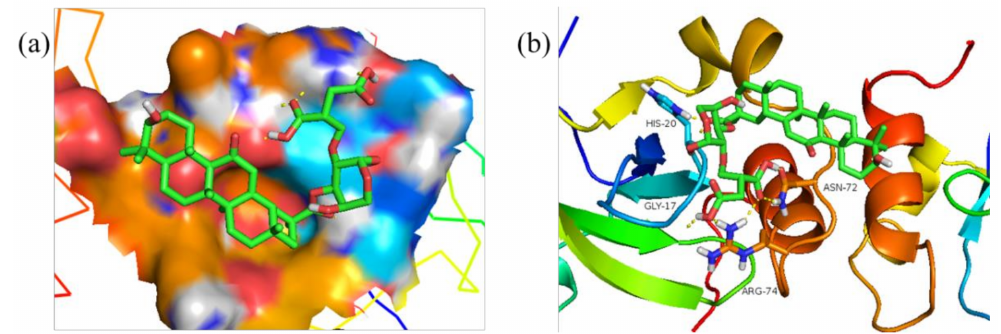
Figure 12. Docking conformation diagram ( a ) and hydrogen bonding diagram ( b ) of GA-BX/AD-g-IA with 3EAE.